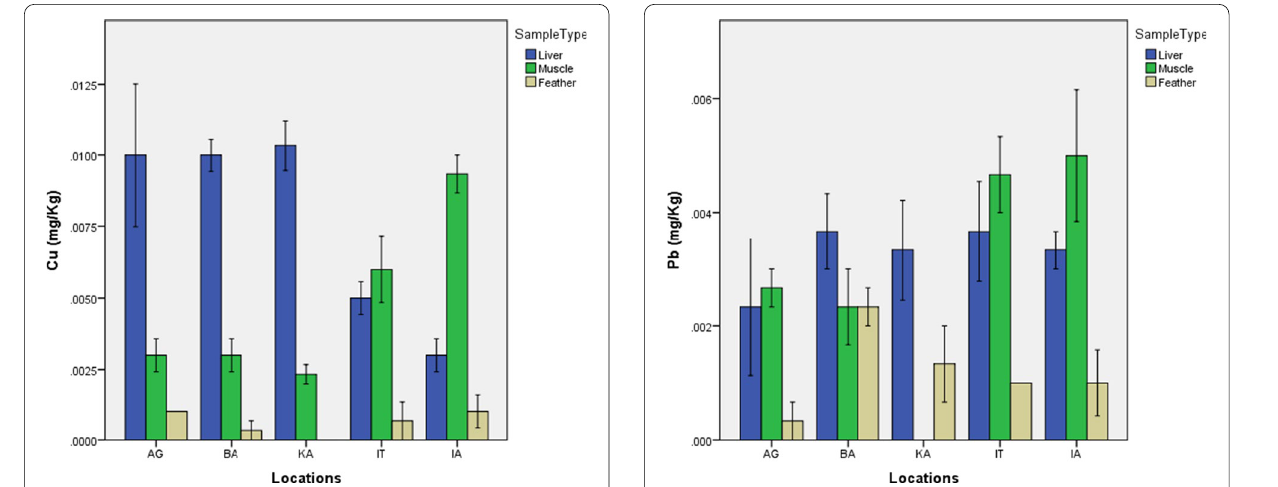
Fig. 3 Level of copper (Cu) in sampling locations (mg/kg)